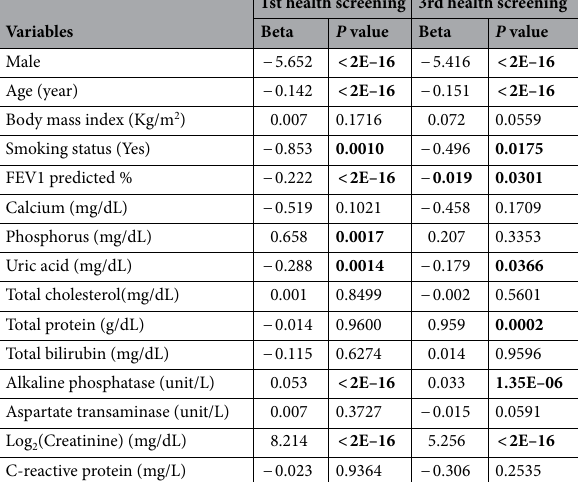
Table 2. Associations between clinical and serum parameters measured at the first and third health screenings and the rate of FEV1 decline. Bolds represent significant results ( P <